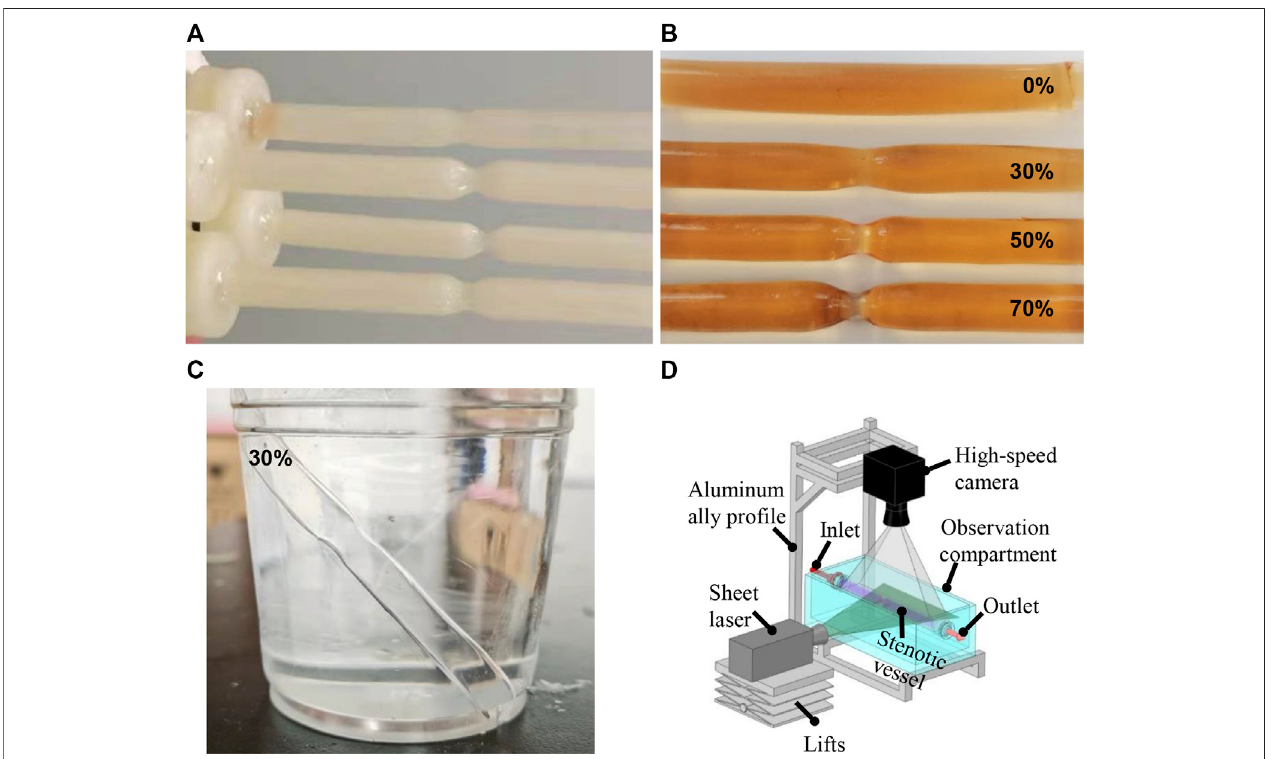
FIGURE 1 | Water-soluble inner core (A) and silicone vessels (B) with different degrees of stenosis. Silicone tube in glycerol and aqueous solution with the weight ratio of 1:1 (C) . PIV experimental setup (D) .